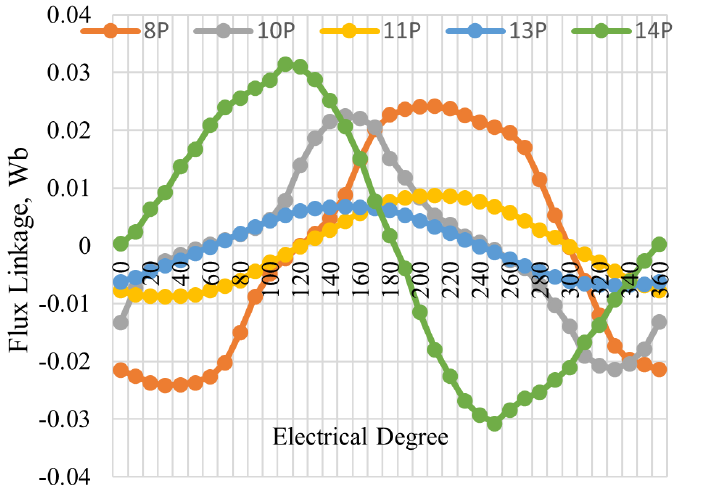
Figure 7. No-load flux of different rotor